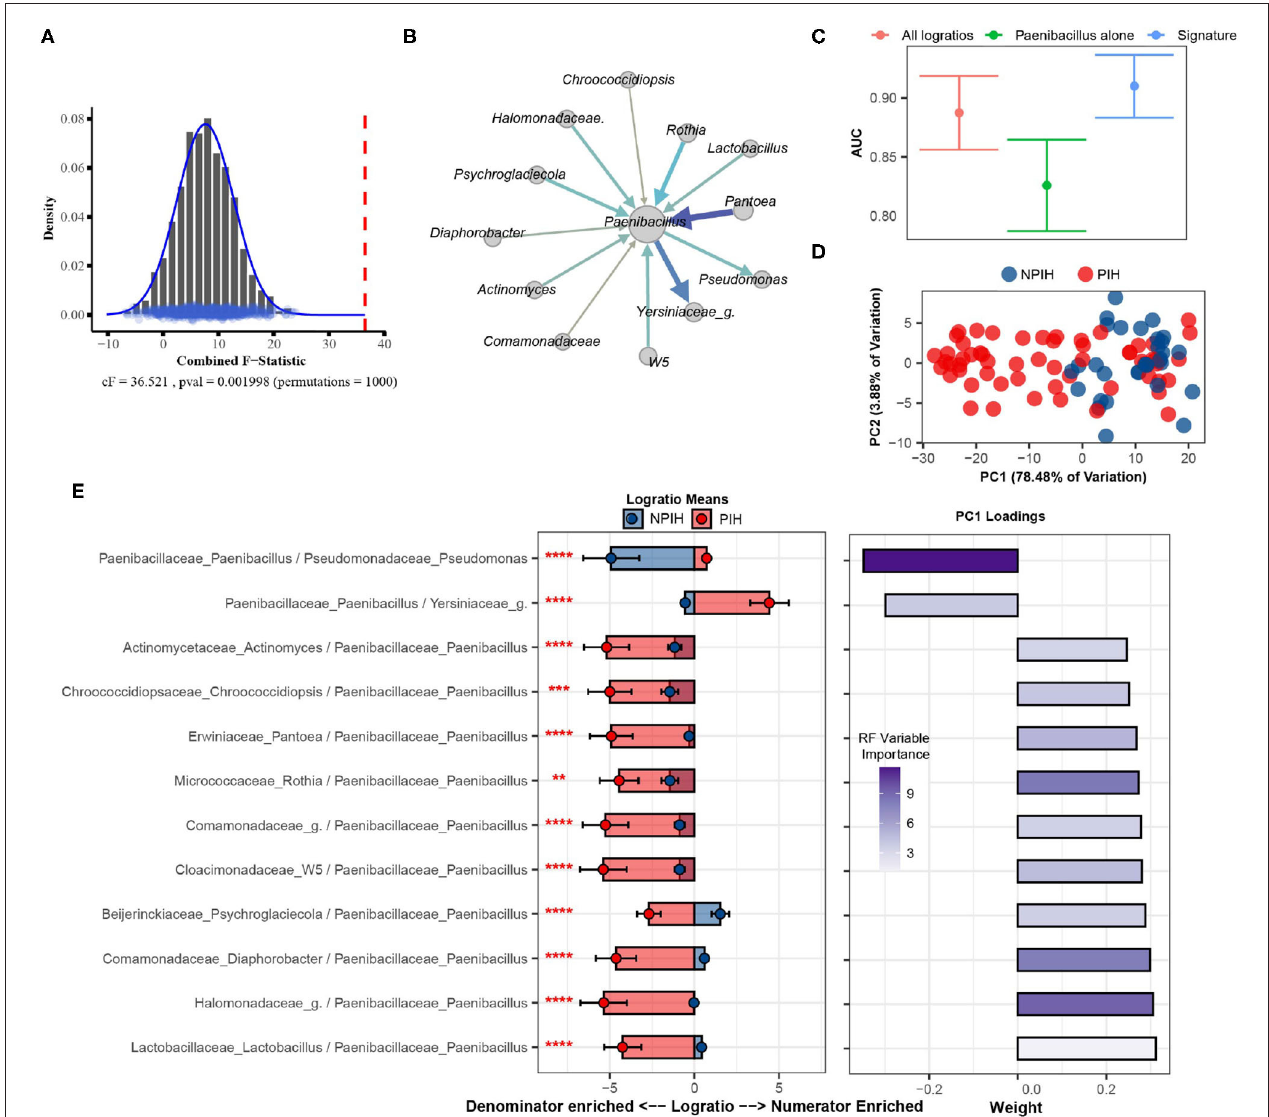
FIGURE 5 | SelEnergyPerm case study examining the association between Ugandan infant’s cerebrospinal fluid microbiomes and post-infectious hydrocephalus using 16S data. (A) SelEnergyPerm permutation test results displaying the null distribution of the cF statistic (Histogram, Density, and Points) and the empirical cF statistic (dashed red vertical line). (B) Random forest (RF) importance weighted directed logratio network (edges point from numerator to denominator) of the SelEnergyPerm selected signature (nodes taxa, node size weighted degree, edges logratio, edge width/color RF variable importance). (C) ROC (Receiver = = = = Operator Characteristic) comparisons of disease status discrimination using RF. Models were trained with repeated ( r 50) 10-fold cross-validation using either the = SelEnergyPerm Signature, all logratios, or Paenibacillus alone. (D) Principal component analysis using the SelEnergyPerm signature. (E) (Left) logratio means comparison (NPIH/PIH) of each logratio included in the SelEnergyPerm signature. (Right) Loading weights of the first principal component. Significance codes (*, **, ***, ****) indicate BH corrected p -value < (0.05, 0.01, 0.001, 1e-4) for NPIH vs. PIH Wilcoxon Rank Sum Test. For the logratio means, positive values indicate numerator more abundant than the denominator and negative values indicate the denominator is more abundant numerator. Error bars indicate the 95% CI of the mean. Notably, error bars that do not span 0 indicate numerator/denominator is on average more abundant than the opposite.